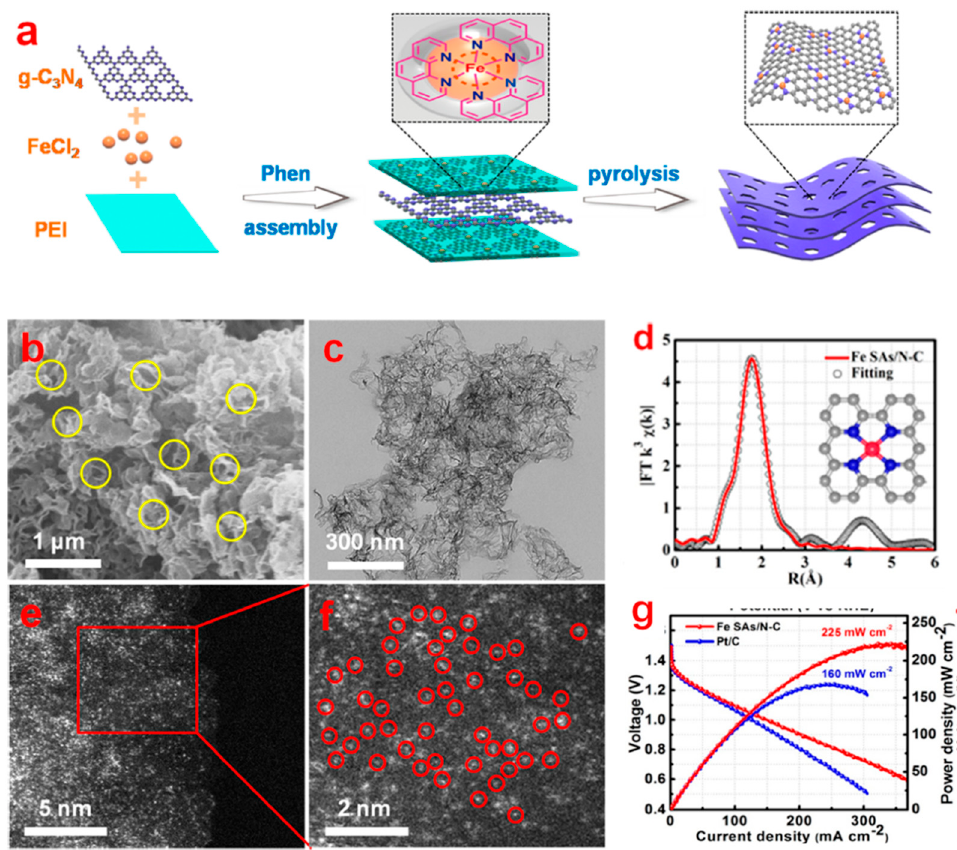
Figure 4. Schematic illustration of the synthetic strategy for single Fe atoms on porous N-doped carbon (Fe-SAs/N–C) ( a ), SEM image ( b ), Transmission Electron Microscope (TEM) image ( c ), Fourier transforms Extended X-ray fine structure (FT-EXAFS) fitting curve and the proposed atomic structure model ( d ), aberration-corrected high-angle annular dark-field scanning TEM (AC HAADF-STEM) images ( e , f ), and polarization curves in a zinc–air batteries ( g ) [68].